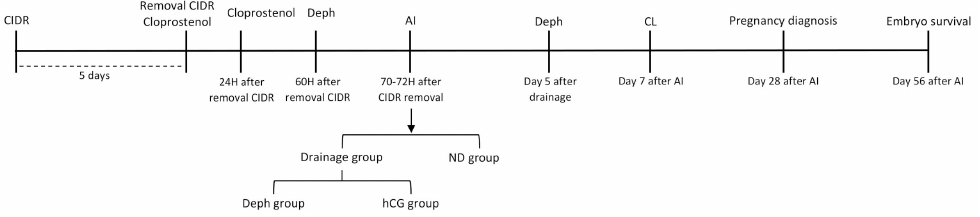
Figure 1. Fixed-time artificial insemination protocol and experimental design used in 180 cows (AI: artificial insemination; CL: corpus luteum observations; Deph: Dephereline; ND: non-drainage